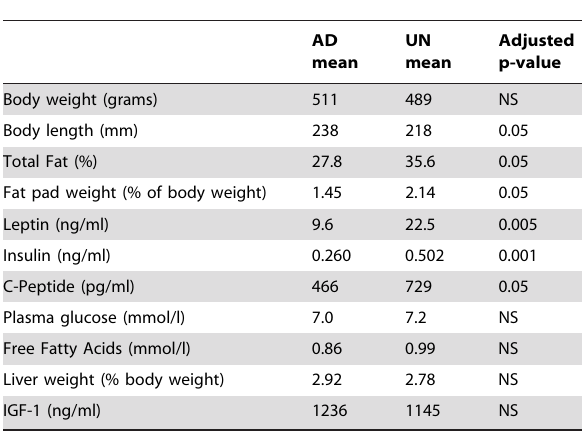
Table 2. Phenotype data, day 110 male offspring.